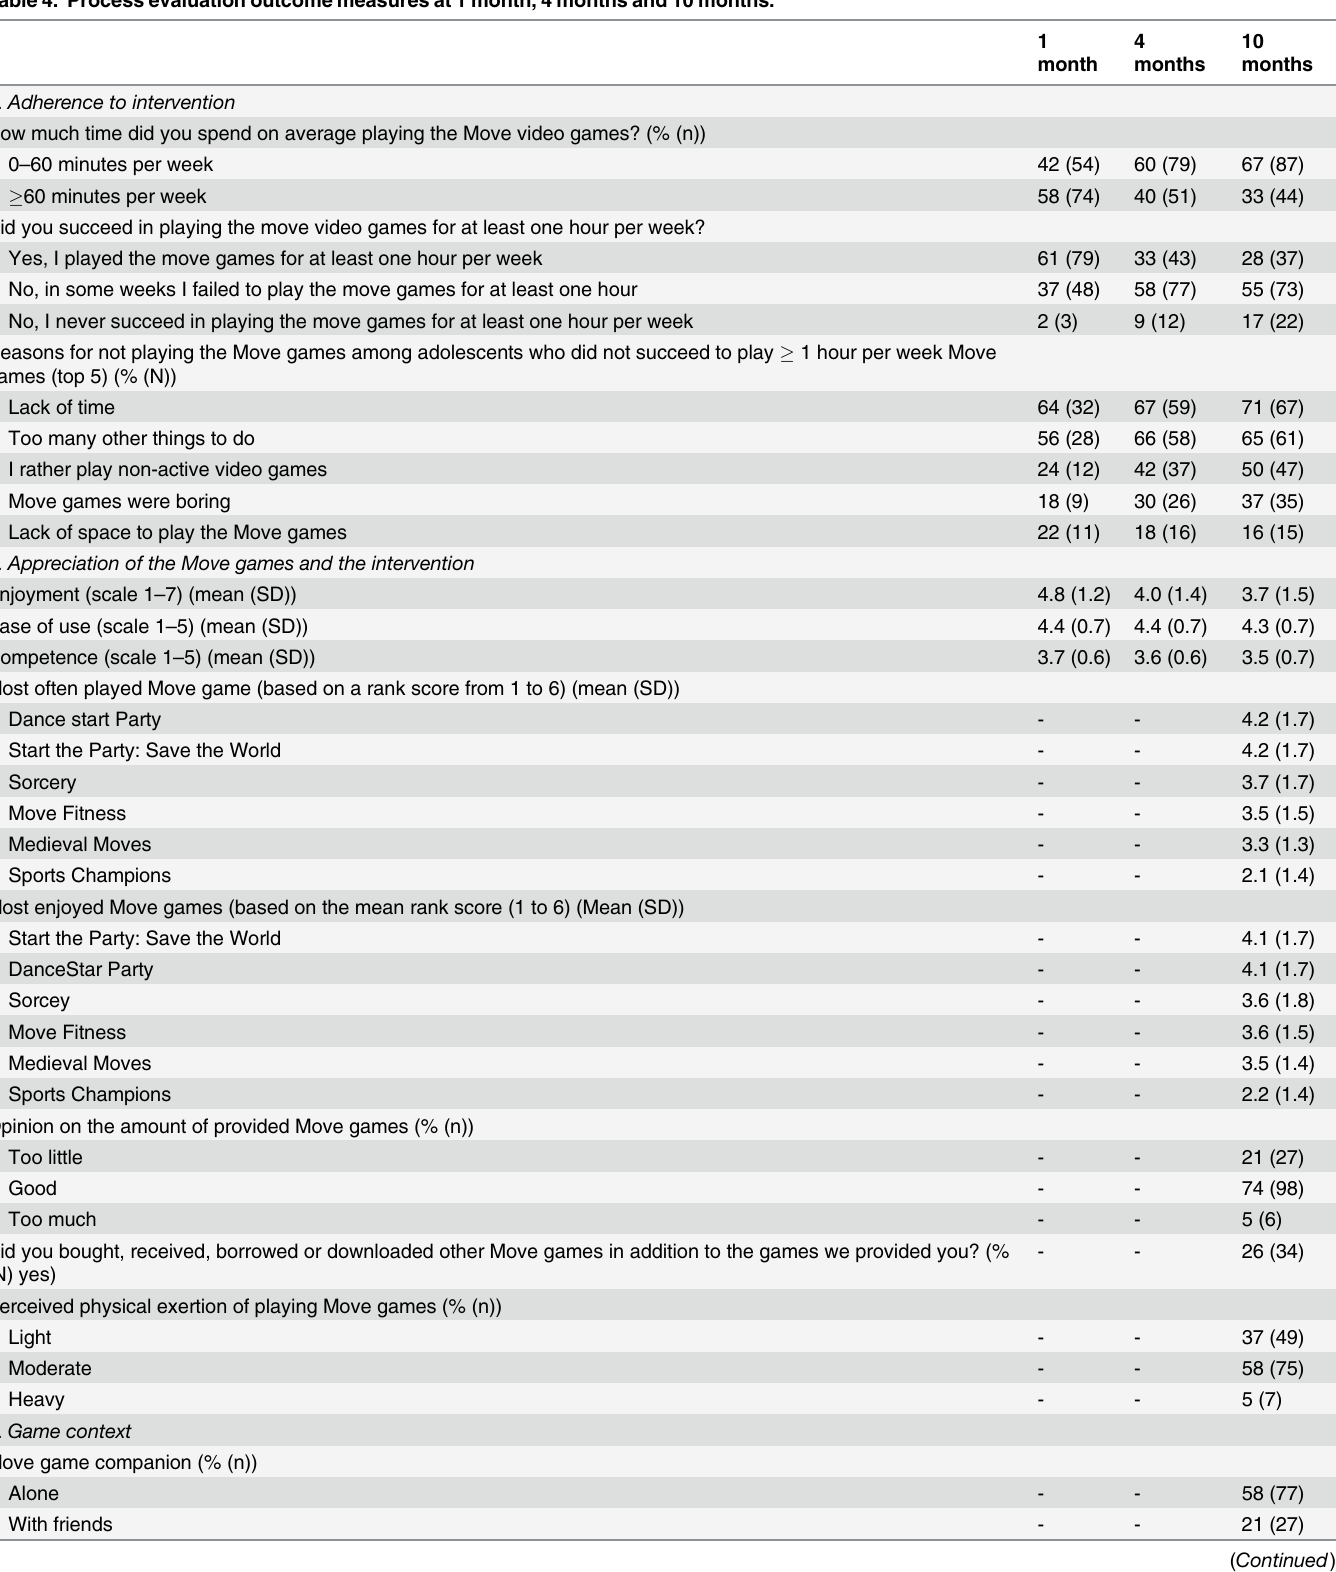
Table 4. Process evaluation outcome measures at 1 month, 4 months and 10